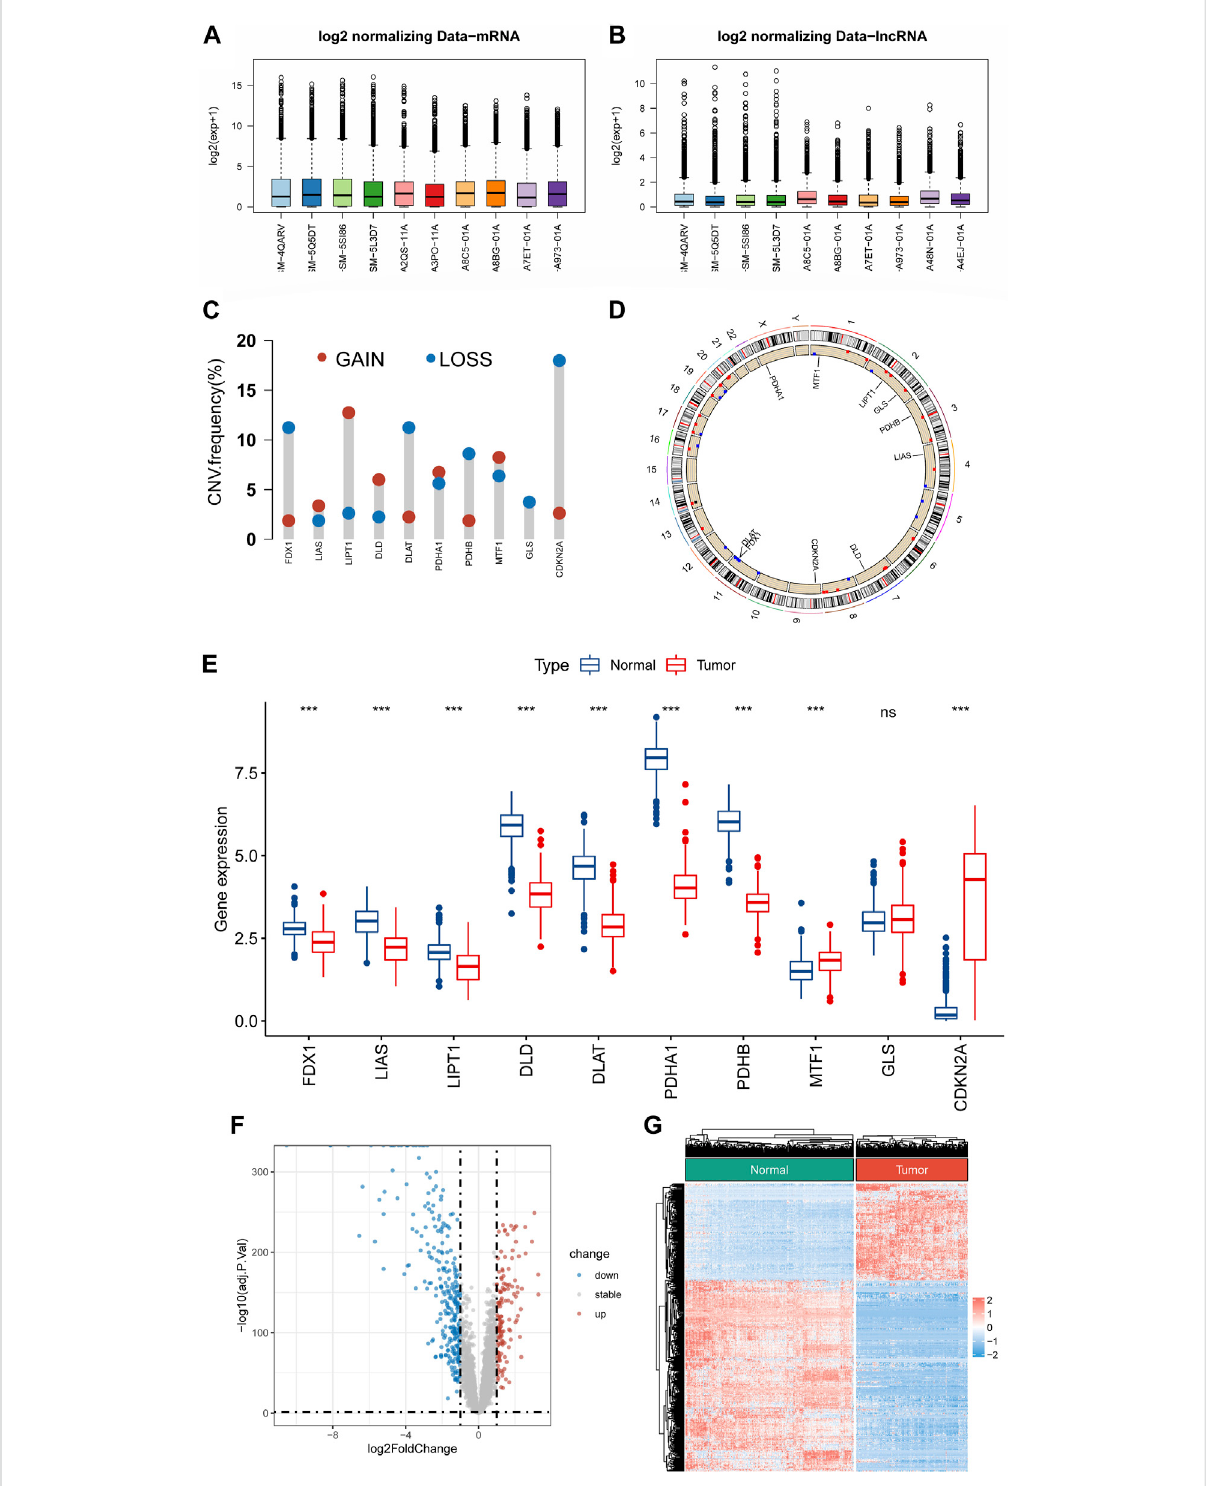
FIGURE 2 Identi fi cation of CRLs in STS. (A,B) Boxplots of mRNA and lncRNA expression pro fi le after batch effect correction. (C) The frequencies of CNV gain and loss of CRGs. (D) The location of CRGs on chromosomes. (E) The expression level of CRGs between STS and normal tissue. (F,G) The volcano plot and heat map of the differentially expressed